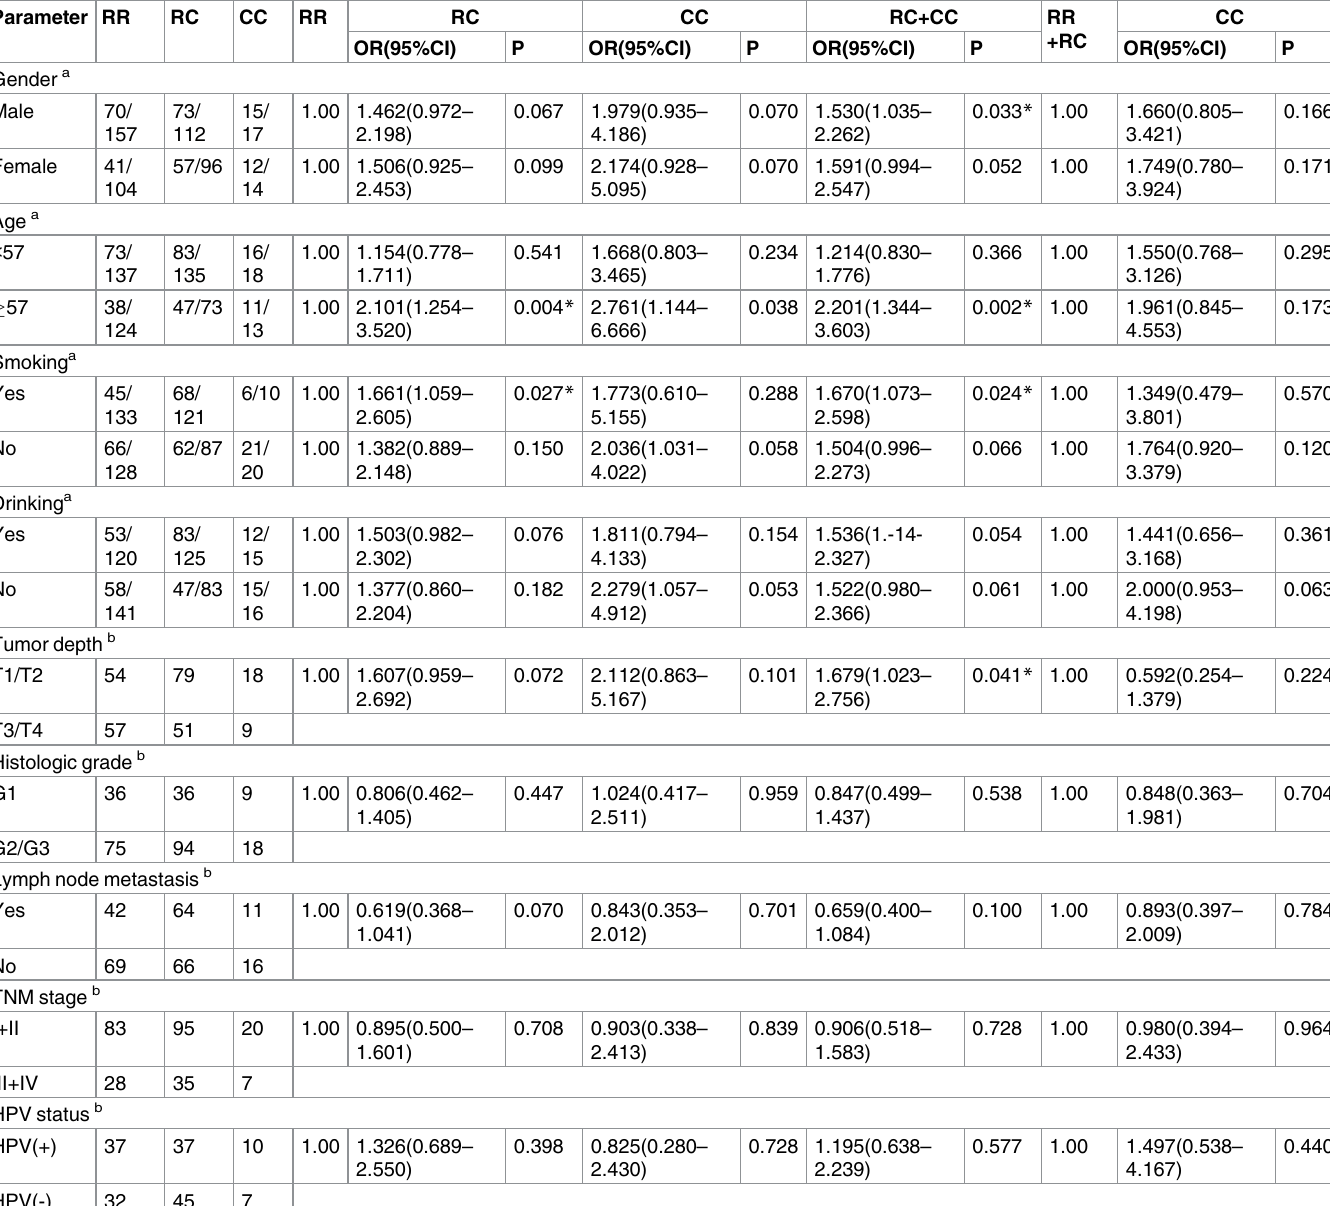
Table 3. Stratification analyses between LMP2 polymorphism and Kazakh ESCC patient clinicopathological